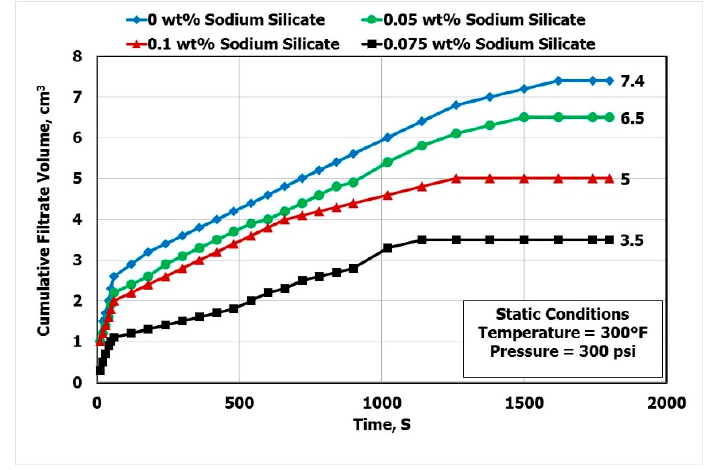
Figure 6. Effect of adding sodium silicate on filtrate volume.